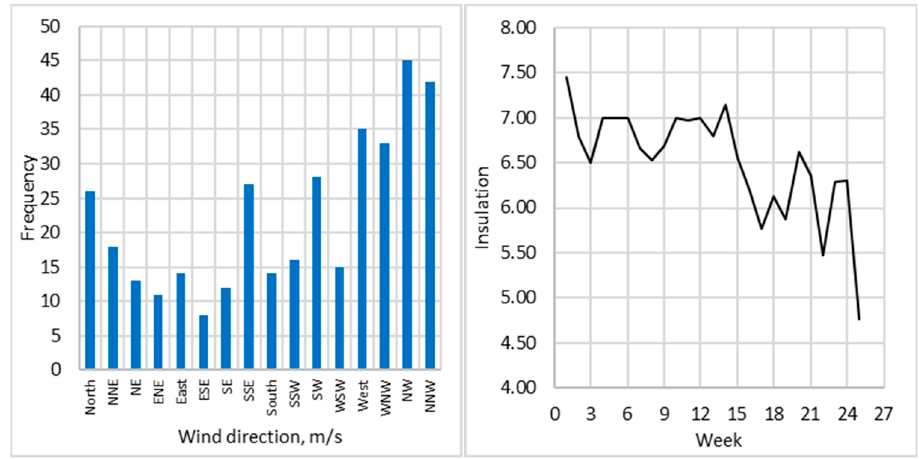
Figure 5. Average queuing time ( left ) and wind speed ( right ).